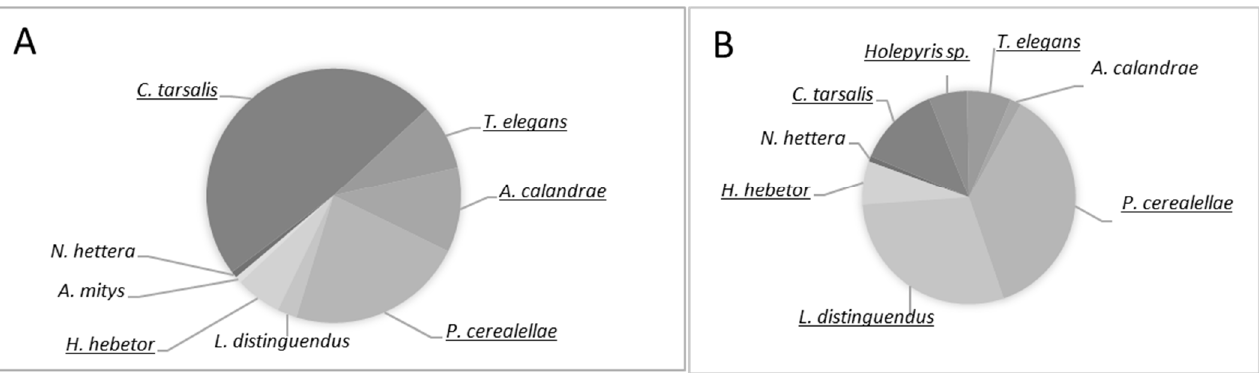
Figure 1. Species dominance at the ( A ) Med. and ( B ) Ar. sites. The names of dominant species are underlined.